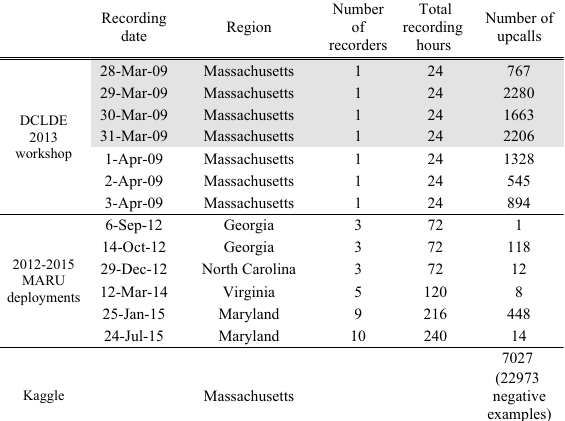
Table 1. Number of upcalls indicates the number of upcalls annotated by trained analysts. For deployments with two or more recorders, the number of upcalls indicates the total number of upcalls detected across all recorders. Shaded rows indicate data used to train neural networks. Non-shaded rows represent evaluation data. Negative examples for the Kaggle data represent the false detections flagged by the analysts as derived from non- right whale